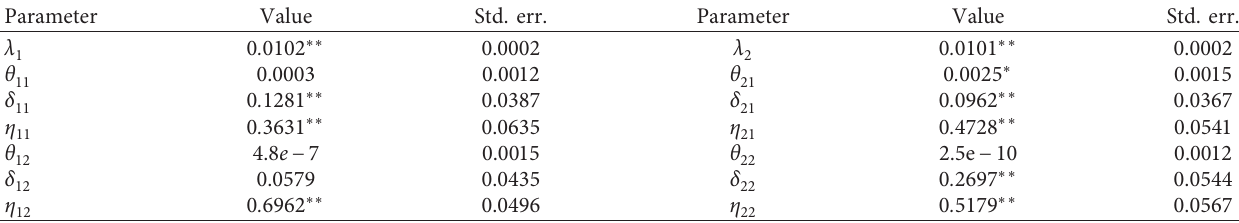
Table 3: Estimation results for ground intensity process.